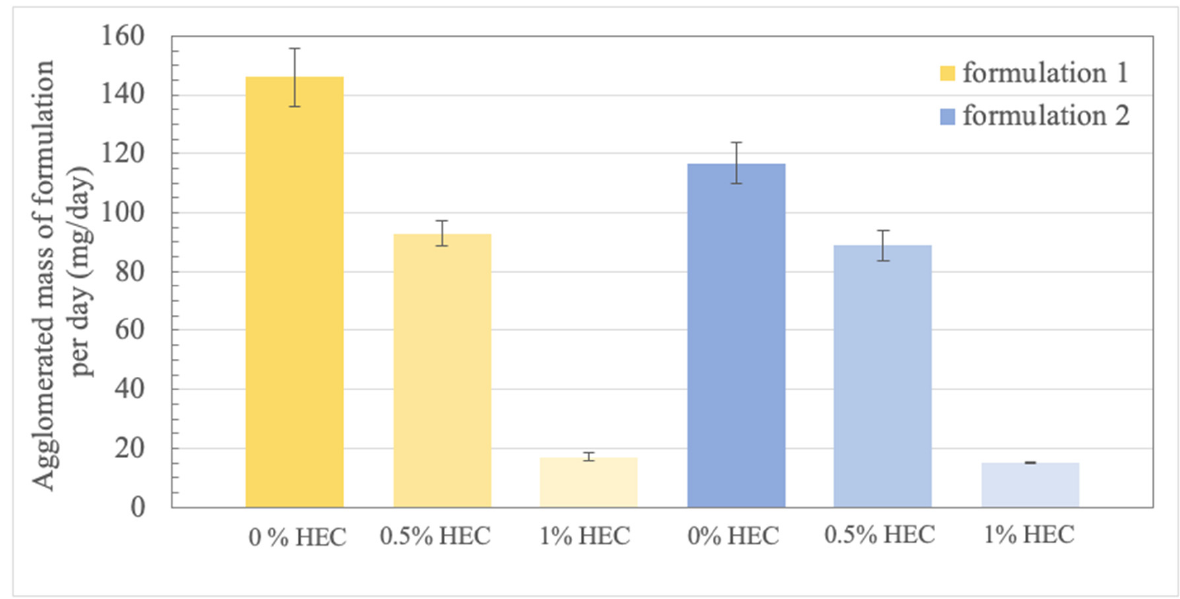
Figure 9. In vitro agglomerated masses per day of formulation 1 (yellow) and formulation 2 (blue) from suspensions without (n = 9), with 0.5% and 1% ( w/w ) hydroxyethyl cellulose (HEC) added to the vehicle as viscosity-enhancer (both n = 3).